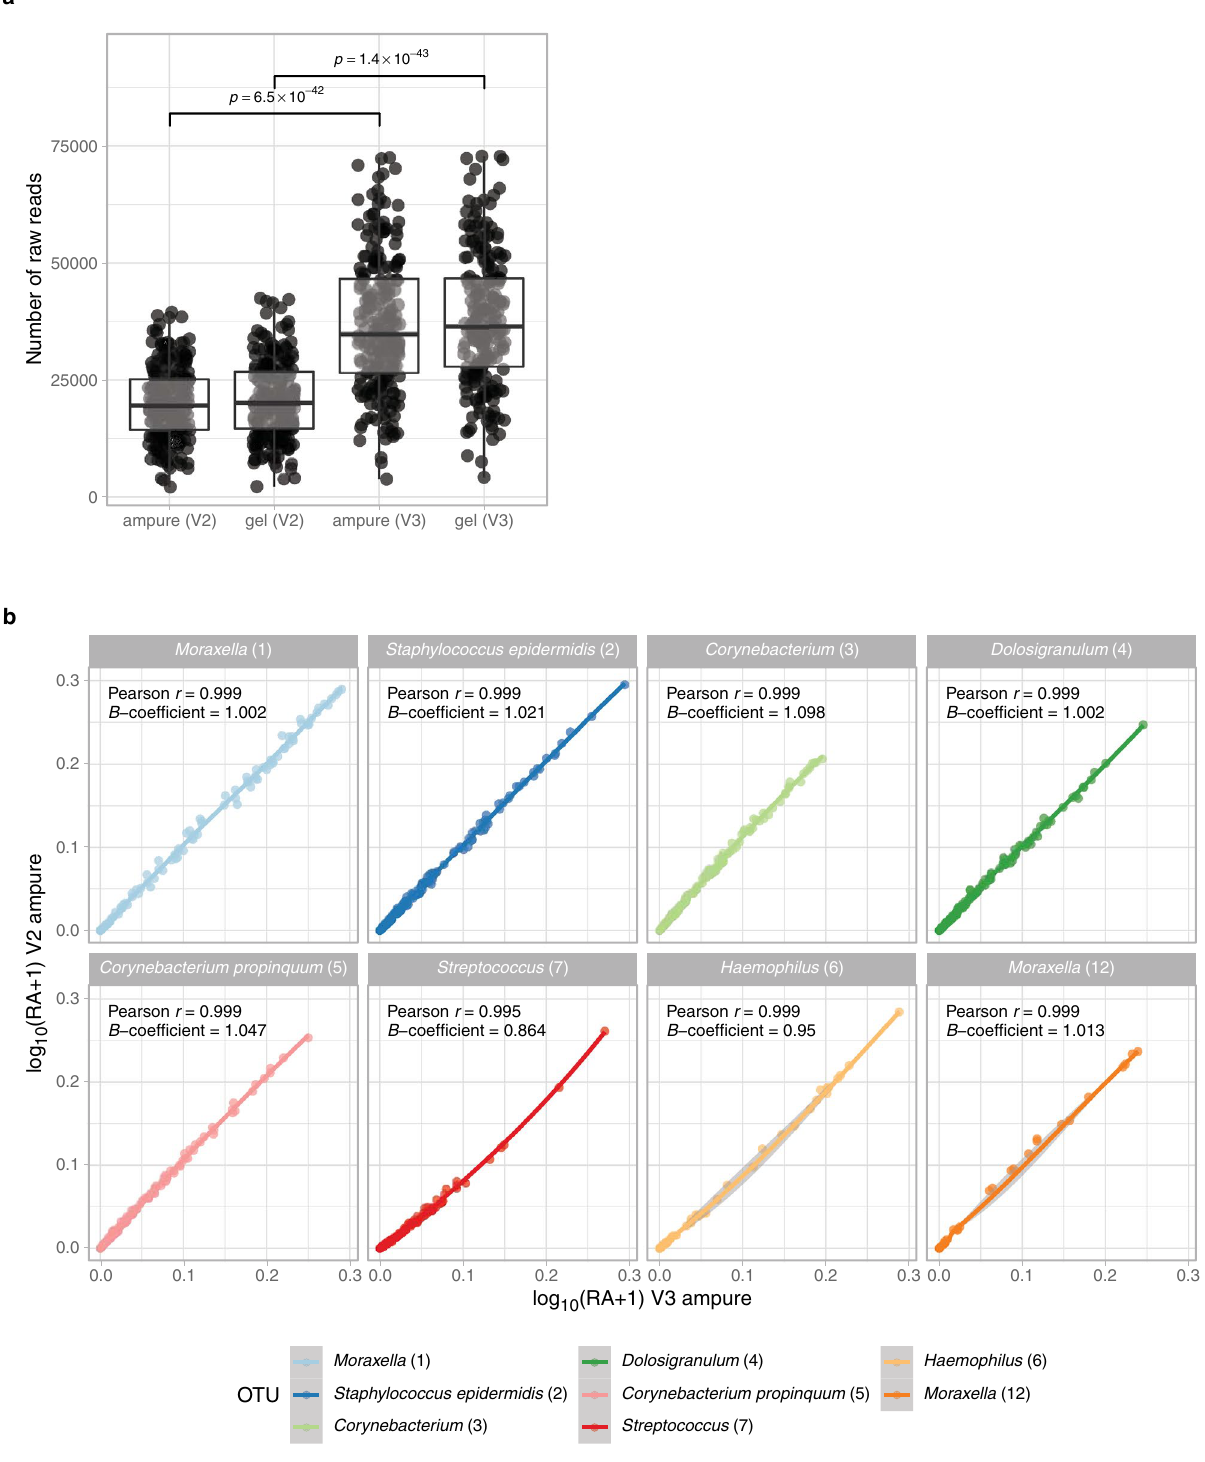
Figure 5. Similarity of a library (n = 214) sequenced by MiSeq V2 and V3 kits. ( a ) Number of reads of samples sequenced by V2 and V3 kit stratified by purification method. Statistical significance in number of reads between V2 and V3 kit was calculated by a linear model. ( b ) Correlation plots visualize log 10 + 1-transformed relative abundances of the top 8 OTUs of a pool purified by AMPure XP, comparing the V2 or V3 reagent kit. For each OTU, the Pearson correlation coefficient and regression coefficient was calculated. Both the correlation coefficient and almost all slopes show a value close to 1.0, indicating a near perfect correlation between purification methods for these